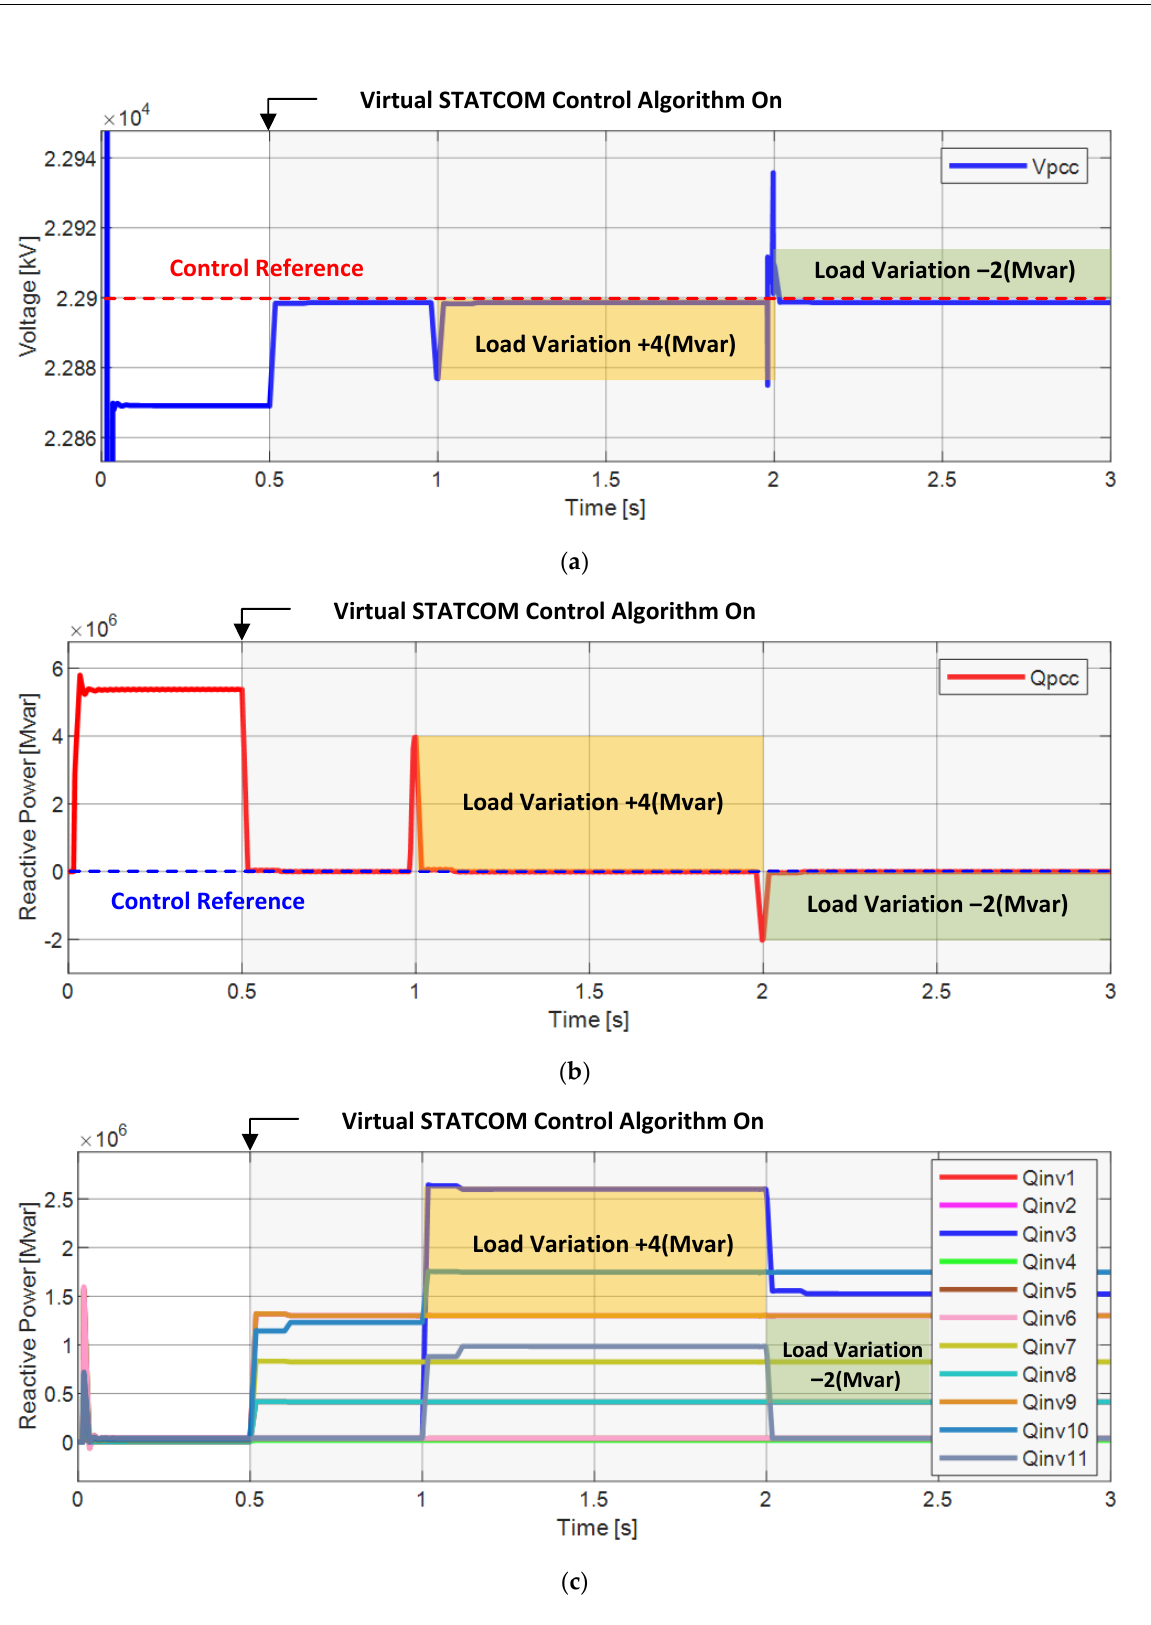
Figure 10. Virtual STATCOM Power Quality Compensation ( a ) PCC Voltage, ( b ) PCC Reactive Power, ( c ) Compensation Amount for Inverter Reactive Power.